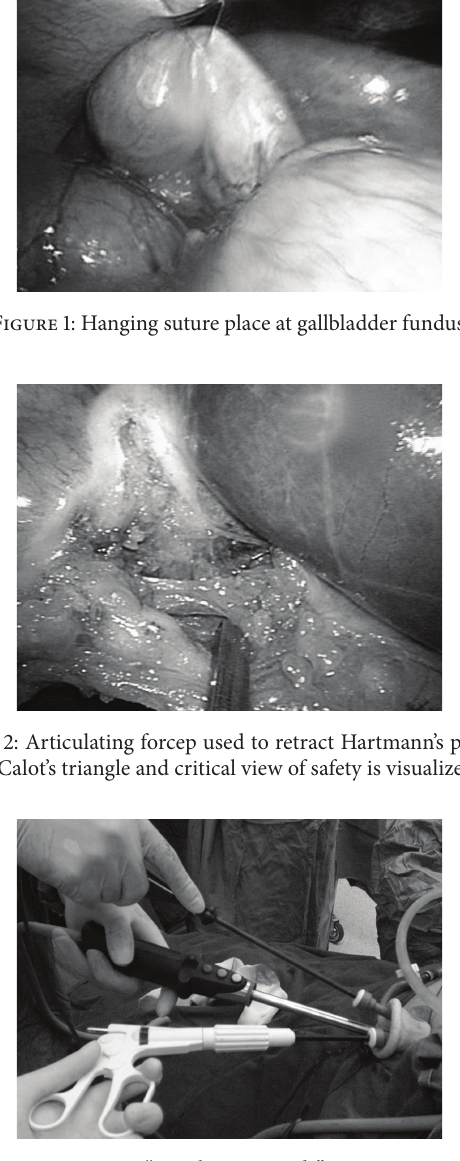
Figure 3: “Snooker cue guide”